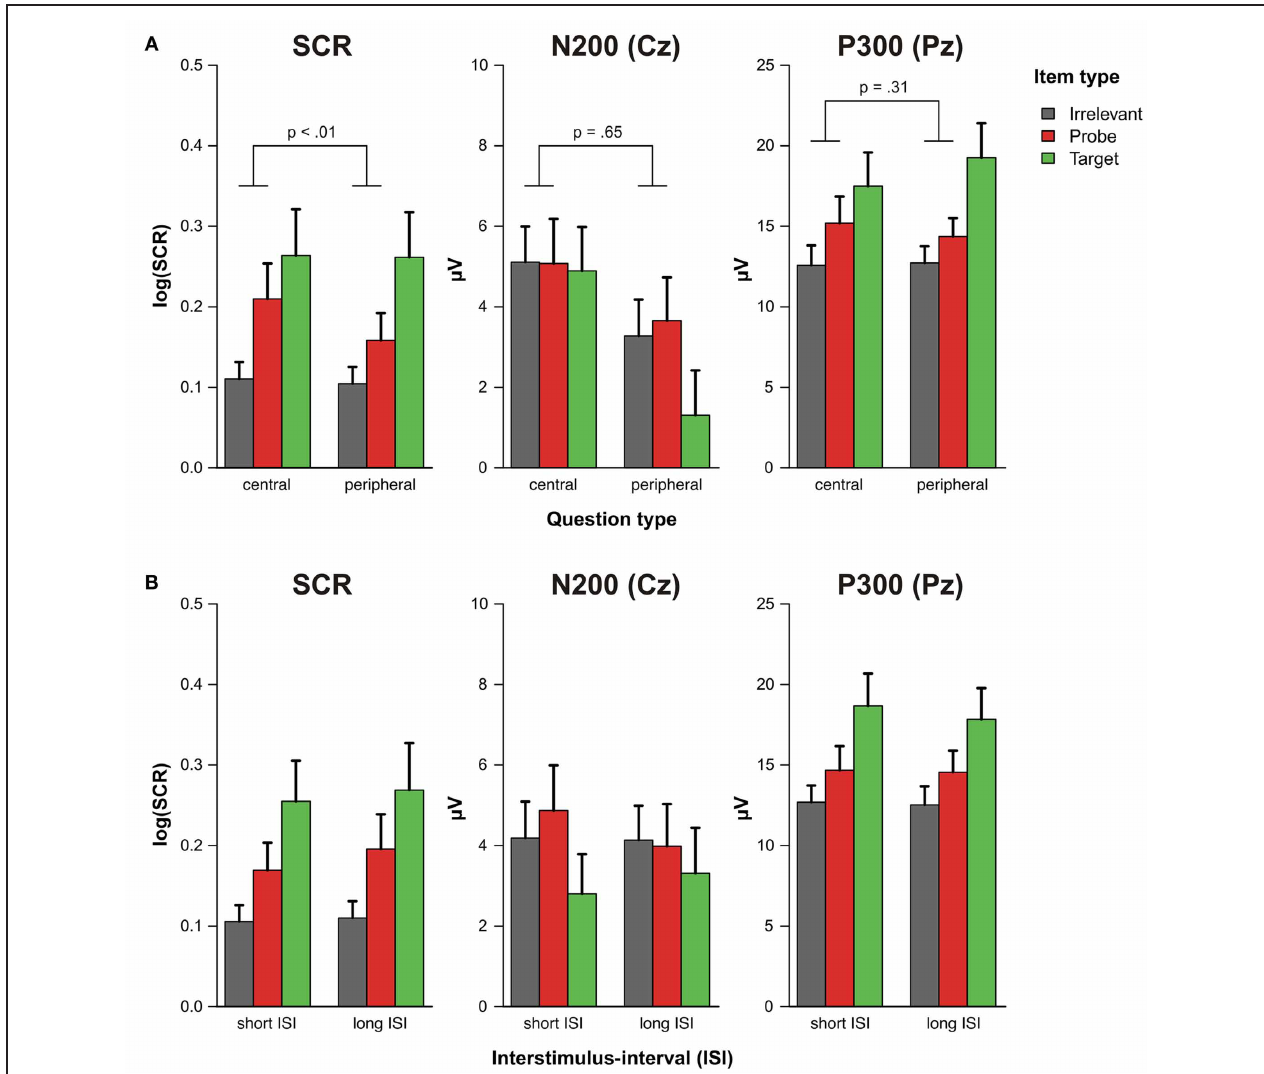
FIGURE 3 | Log-transformed skin conductance response amplitudes, N200 and P300 amplitudes (A) as a function of question set (central vs. peripheral) and item type (target, probe, irrelevant) and (B) as a function of interstimulus-interval (short vs. long) and item